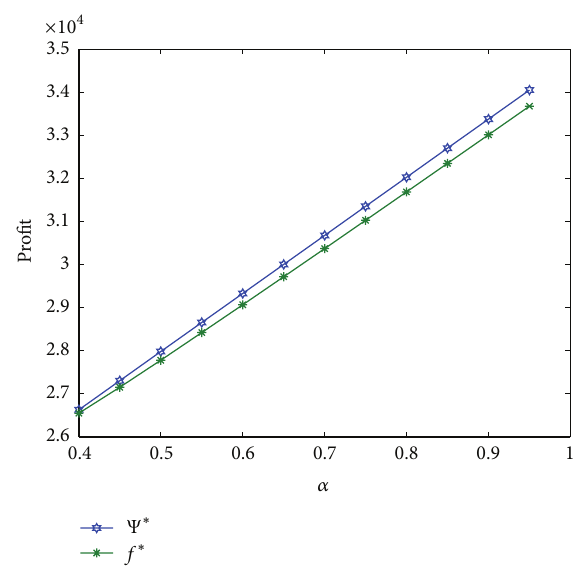
Figure 11: Impacts of 𝜆 on 𝑞 ∗ and 𝑞 ∗ 𝑅 .